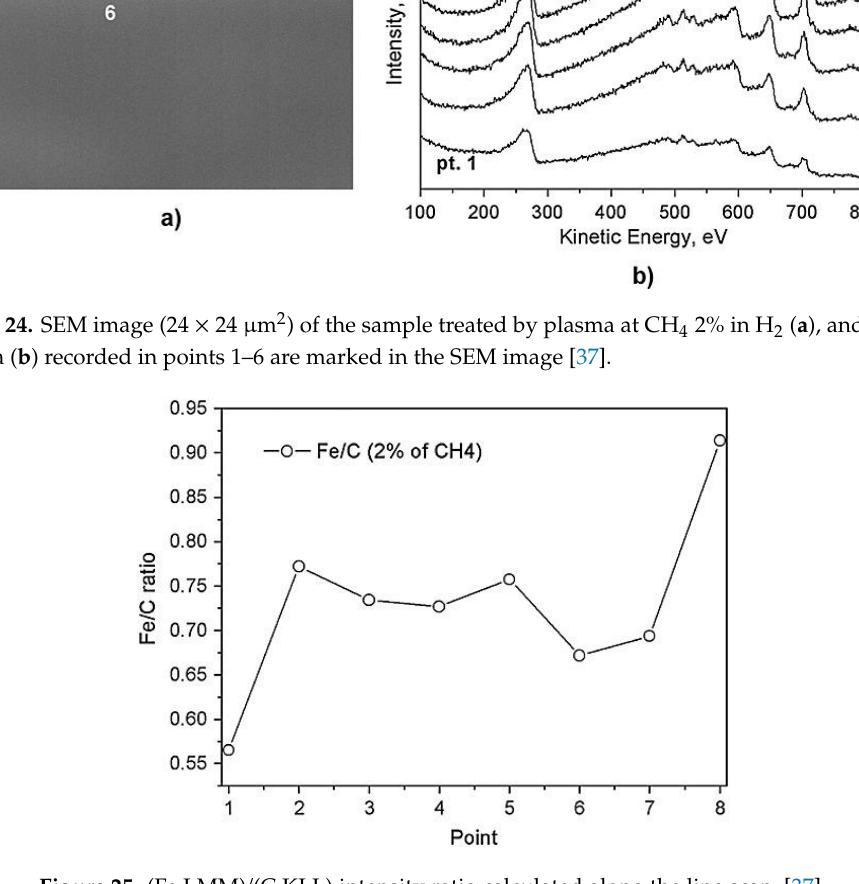
Figure 25. (Fe LMM)/(C KLL) intensity ratio calculated along the line scan. [37].